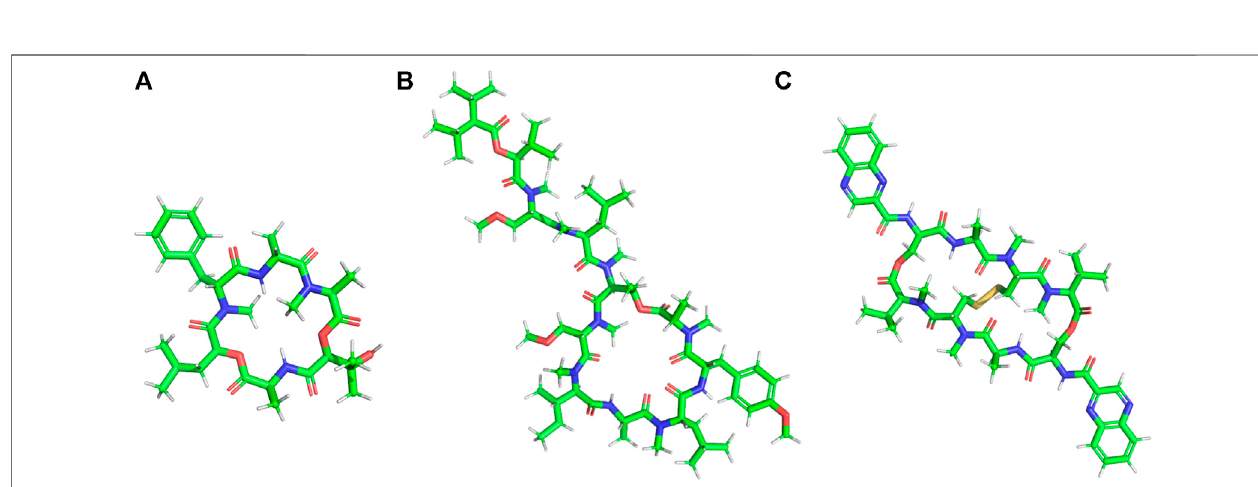
FIGURE 4 | Different modes of cyclization in cyclic AMPs. (A) Homodectic cyclic peptides (head-to-tail cyclized): Guangomide A. (B) Heterodectic cyclic peptide (head/tail-to-side chain or side chain-to-side chain cyclized): Coibamide A. (C) Complex cyclic peptide: Triostin A.